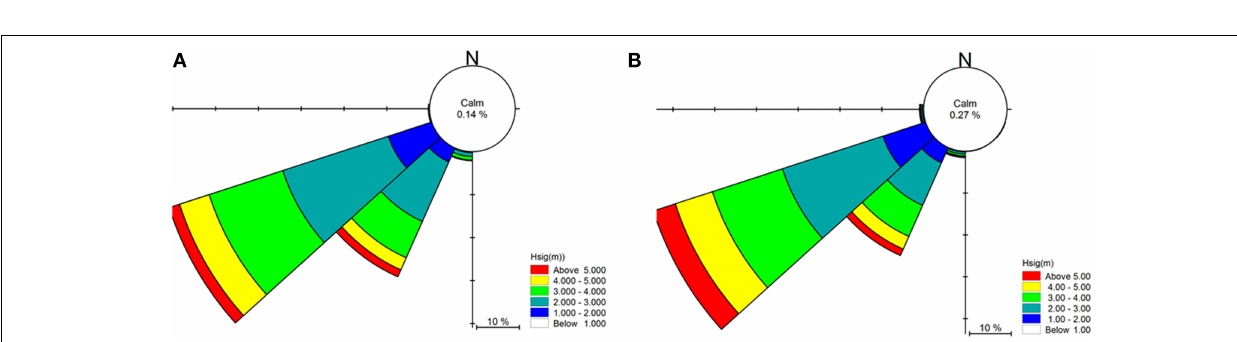
FIGURE 3 | Summary of significant wave heights (Hsig), direction and percentage occurrence for Cape Otway showing prevailing swell conditions for (A) the year 2000 and (B) the 10-year average